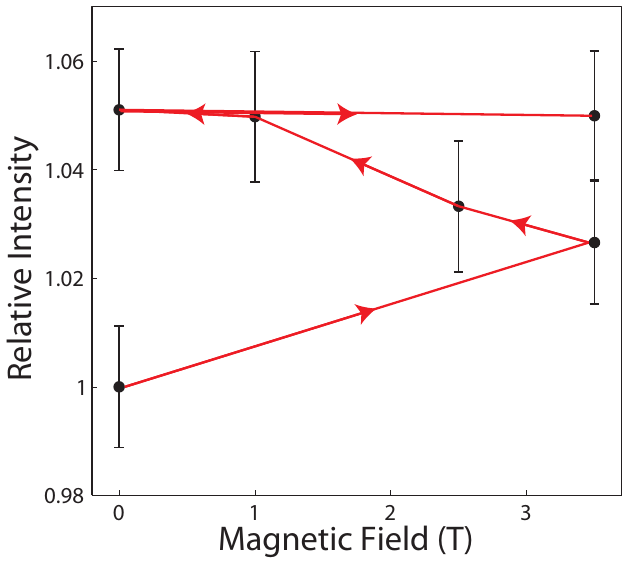
Figure 6. Integrated intensity of the gel signal as a function of magnetic field